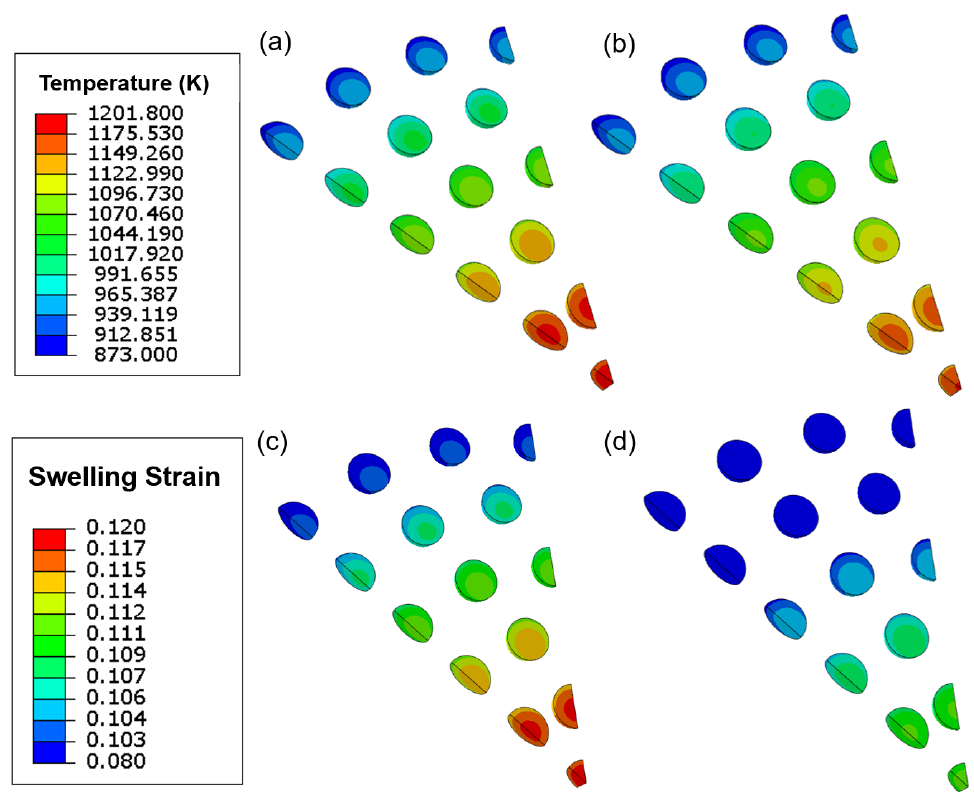
Figure 2. Temperature and swelling distribution contour plots on the 230th day of burnup: ( a ) tem- perature without hydrostatic pressure; ( b ) temperature with hydrostatic pressure; and ( c ) swelling without hydrostatic pressure; ( d ) swelling with hydrostatic pressure.